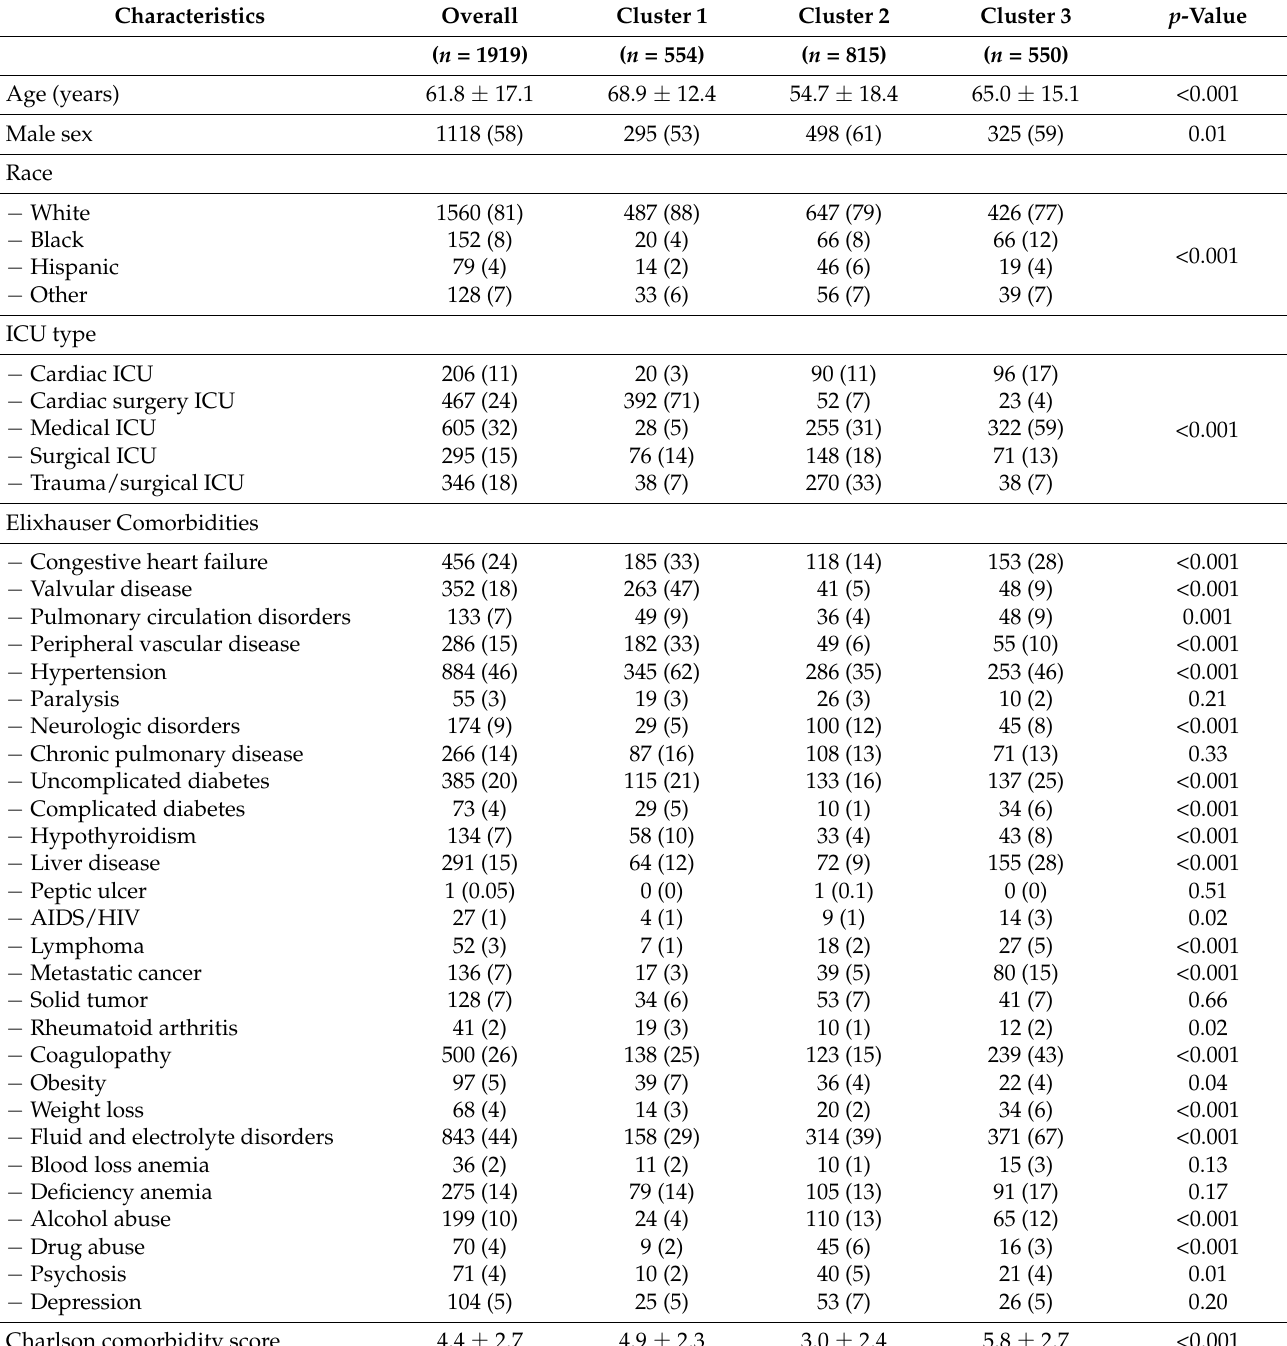
Table 1. Clinical characteristics at ICU admission according to clusters of lactic